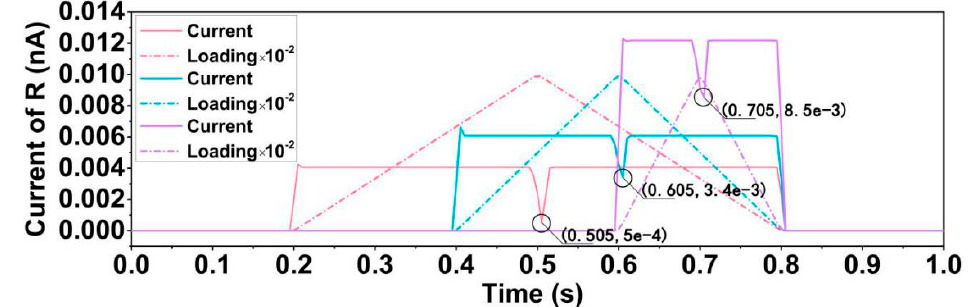
Figure 13. Current response diagram under triangular wave loading with three different loading slopes. Each color represents a different loading type. The black circle shows where the peak value arrives. The triangular waves reach the peak at 0.5 s, 0.6 s, and 0.7 s, respectively. The peak values of the loading are the same. (The current is the absolute value here) (Current of R shows the current of the resistance).